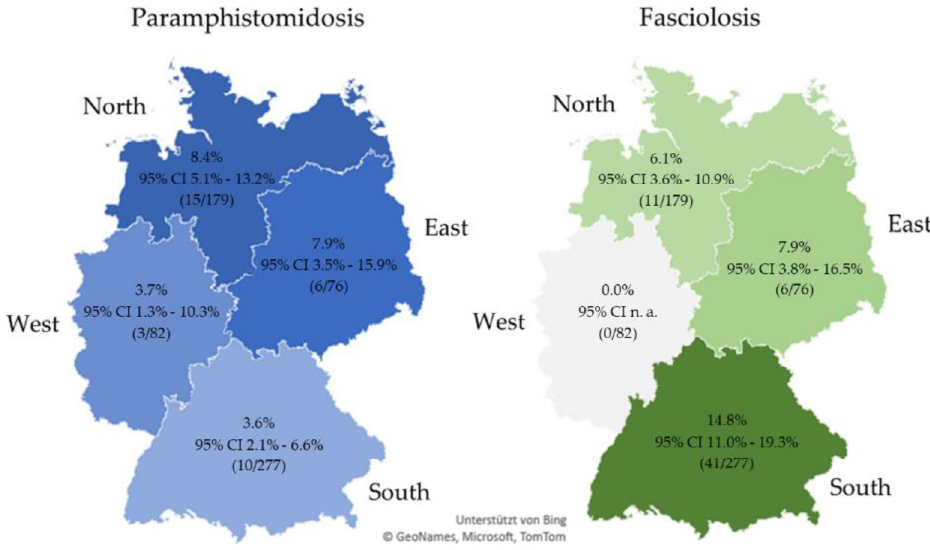
Figure 1. Prevalence and 95% confidence interval for rumen fluke and F. hepatica prevalence in German regions (coinfections included). Abbreviations: CI, confidence interval; n. a., not applicable.